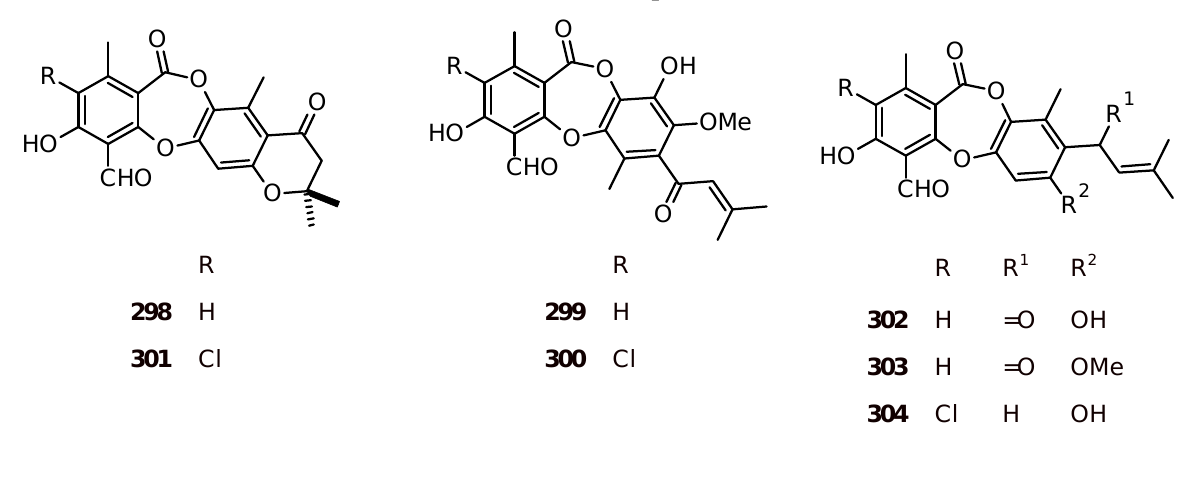
Figure 38. Structures of depsidones 298-304